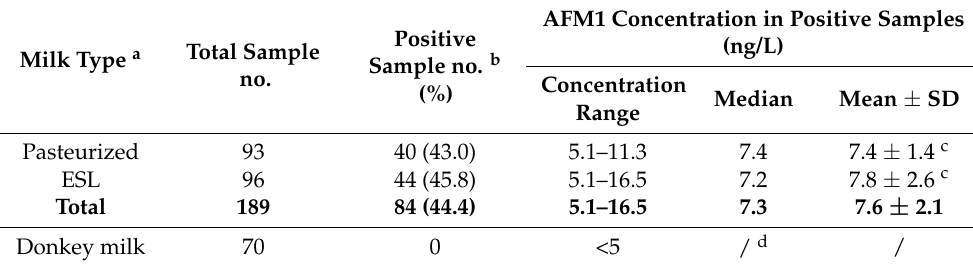
Table 1. Occurrence of AFM1 in three types of milk samples from Xinjiang, China.